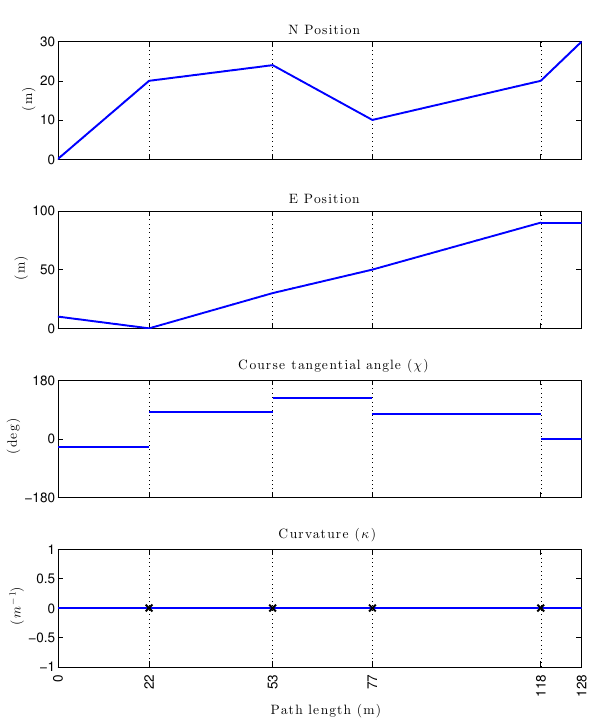
Figure 2: Piecewise linear path geometric properties • Approximating curves, which do not pass through all the given